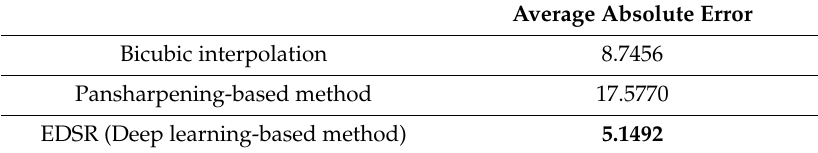
Table 3. Average absolute error on disparity maps for motorcycle image section (pixels that have negative values in the ground truth disparity map are excluded from the analysis, pixels with negative values in the estimated disparity maps are set to zero). Bold format indicates the method providing better